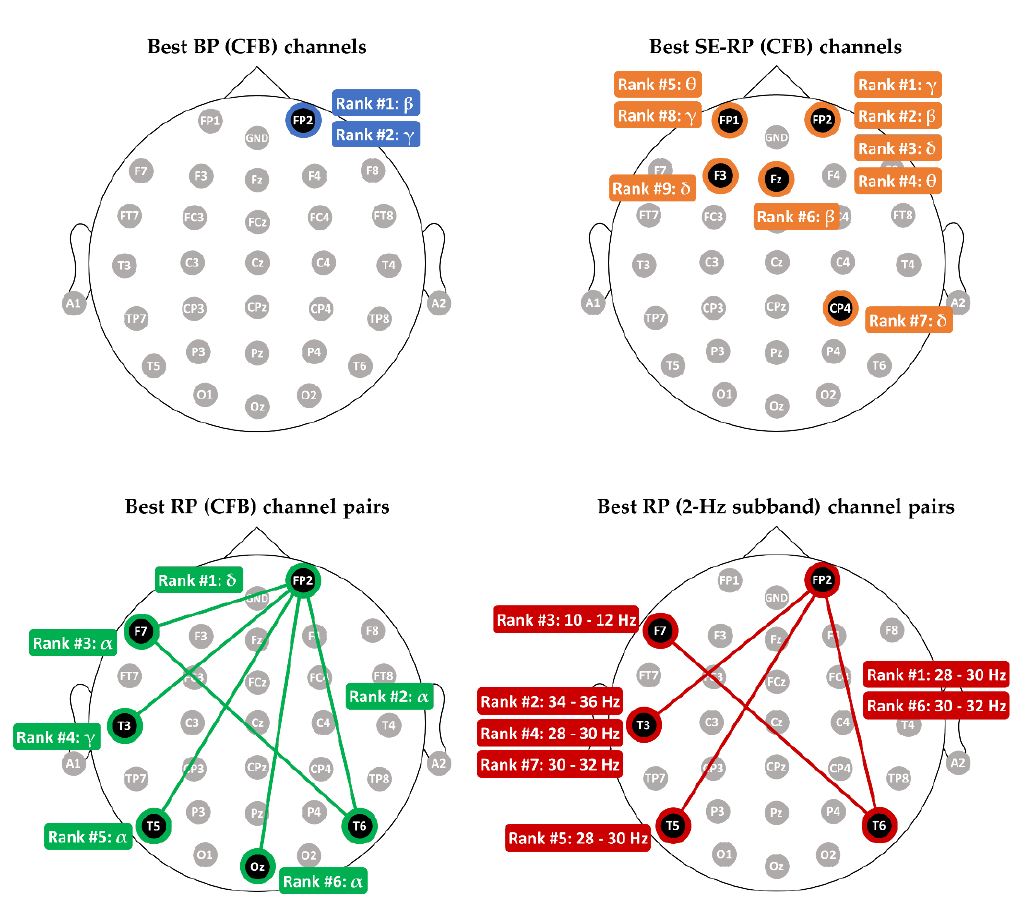
Figure 4. Comparison of MCI-HC classification accuracy among conventional frequency band (CFB)-based BP, SE-RP (CFB), RP (CFB), and 2-Hz-width subband-based RP based on the LDA classifier. The total numbers of feature candidates for the four features are 150, 150, 2175, and 9135, respectively. The best classification accuracies for the four features are 70.59%, 64.71%, 80.39%, and 86.27%, respectively. In terms of RP (2-Hz subband), its accuracy curve reached the maximum 86.27% when the number of top-F-score-ranked-feature increased to 7, which occupy only a very small portion of the whole RP feature candidates (7/9135 = 0.07%).